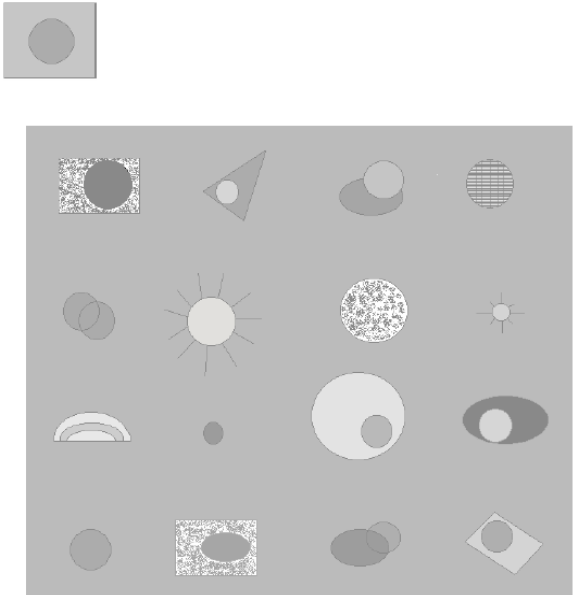
Figura 1 . Exemplo de Item que Compõe o Teste Constância da